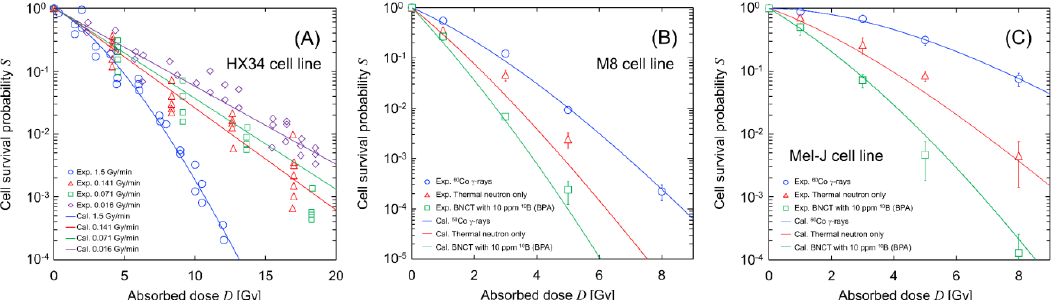
Figure 3. Calculated cell survival curve after irradiations: ( A ) dose-rate effects under 60 Co γ -ray irradiation; ( B ) dose–response curves for the M8 cell line; and ( C ) dose–response curve for the Mel-J cell line. These experimental data were obtained from the literature [39,45], while the predicted curves were described using the model parameters listed in Table 1 and the IMK model. Dose-rates and microdosimetric quantities for 60 Co γ -rays, thermal neutron only, and BNCT with 10 ppm BPA are 1.25 Gy / min and 2.26 keV / µ m, 1.0 Gy / min and 41.36 keV / µ m, and 3.75 Gy / min and 68.50 keV / µ m, respectively. Note that the dose rate for BNCT was calculated from the dose rate for the